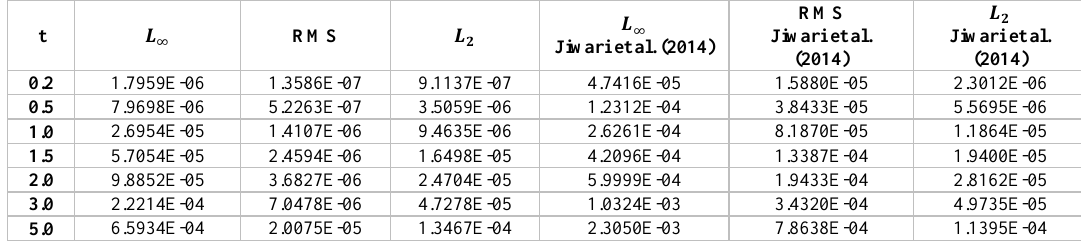
Table 1. 𝐿 and RMS error norms with 𝜁 =0.75 and Δ𝑡 =0.0001 at different t for example , 𝐿 2 ∞